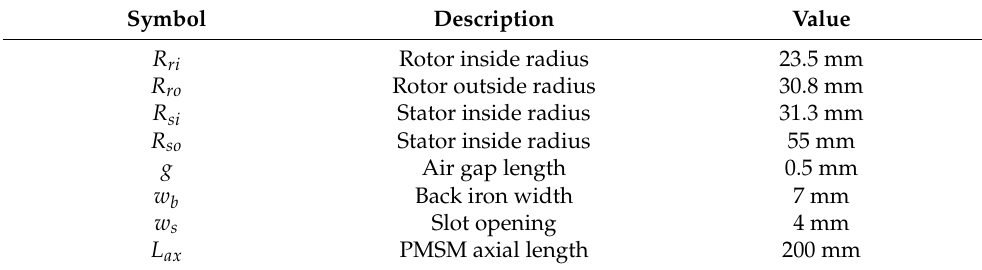
slots N s and 5 magnet pairs N p represent the outcome of the optimization routine. Table 4 presents the relevant parameters of the permanent-magnet synchronous machine. Table 4. PMSM main parameters.